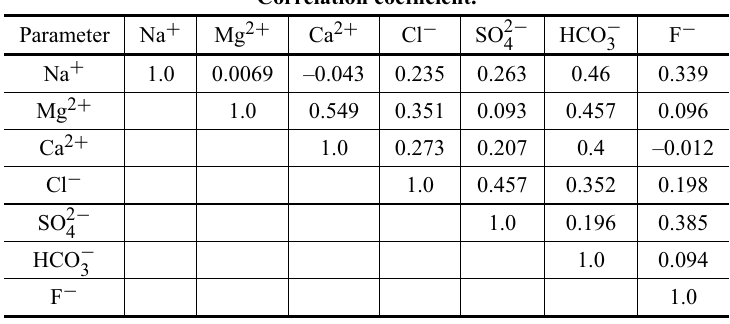
Correlation coefficient.